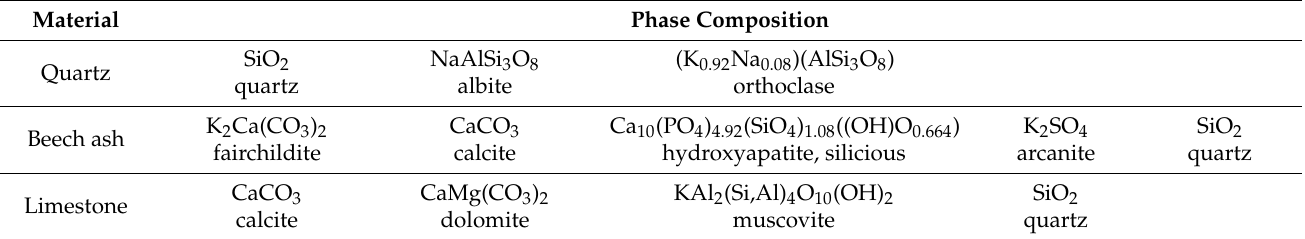
Table 3. Phase composition of natural raw materials